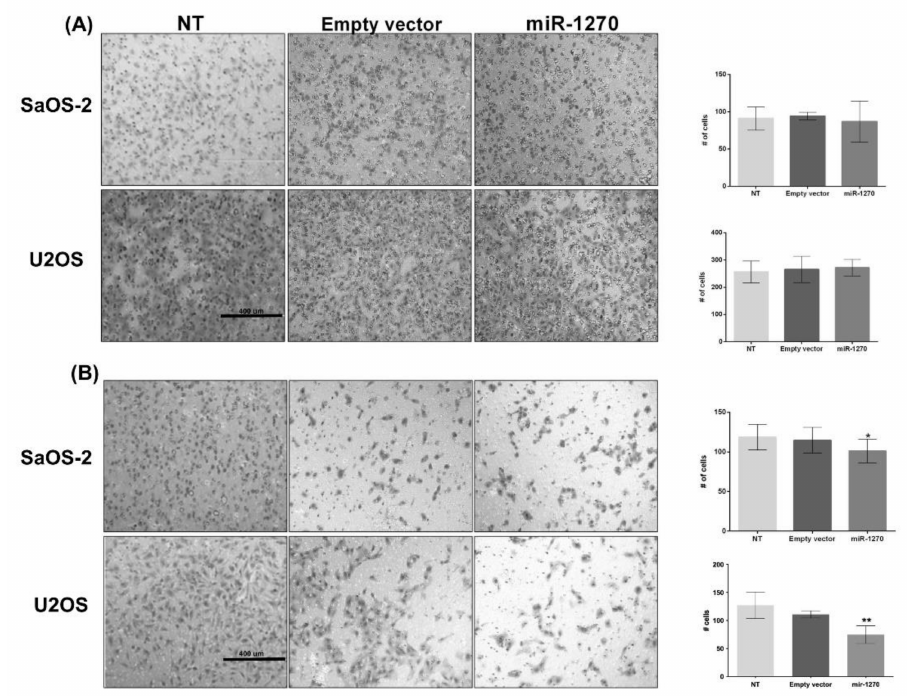
Figure 4. miR-1270 overexpression attenuates the migration and invasion of human osteosarcoma cell lines. The migration and invasion abilities of non-transfected or transfected cells with miR-1270 mimics or empty vectors are shown. ( A ) Representative images of transfected and non-transfected SaOS-2 and U2OS cell migration are shown. Following cell migration assay and cell staining with crystal violet, images of the migrated cells were captured under a microscope (magnification, 10 × ). ( B ) Representative images of transfected and non-transfected SaOS-2 and U2OS cell invasion are shown. Following cell invasion assay and cell staining with crystal violet, images of the invaded cells were captured under a microscope (magnification, 10 × ). Data are expressed as the mean ± SD from three independent experiments. Non-parametric Mann–Whitney U test was performed. * p < 0.05 and ** p < 0.01. miR-1270,